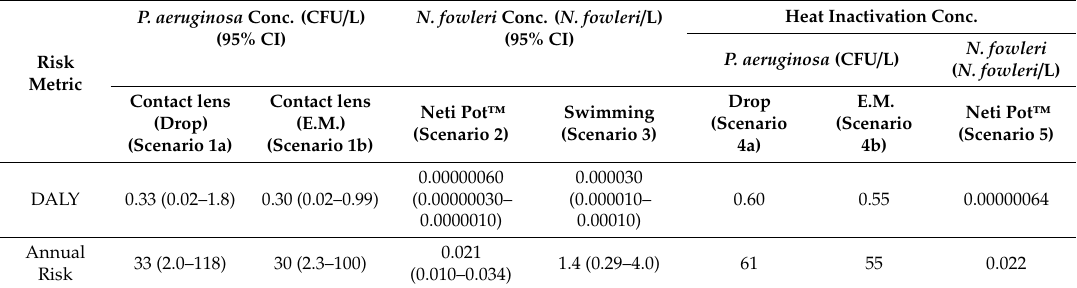
Table 6. Concentration of P. aeruginosa and N. fowleri before and after heat inactivation 1 .